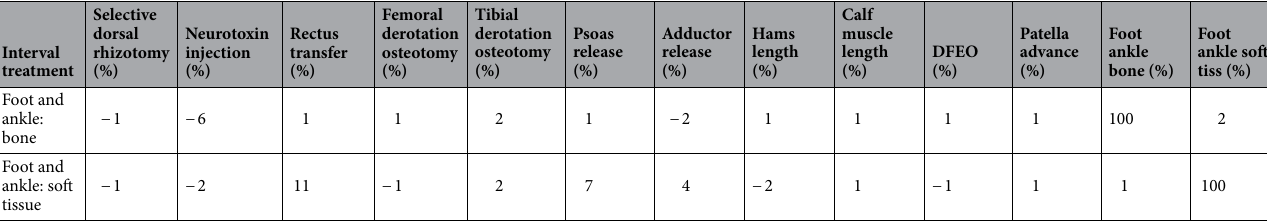
Table 4. Effect of matching on balance of prior and interval treatment.